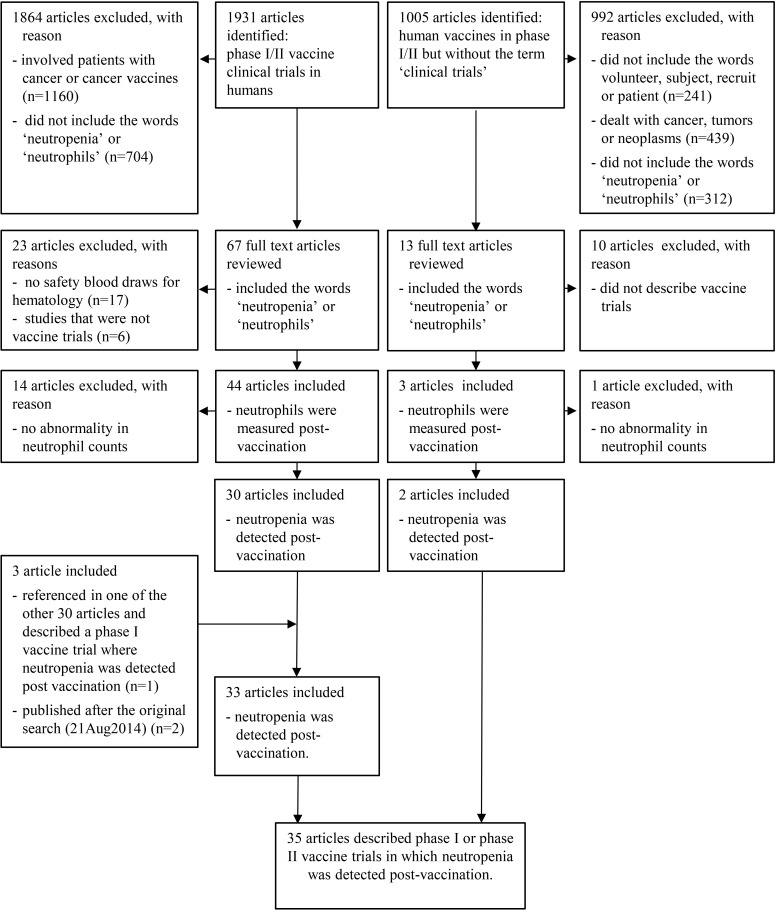
Literature search flow-chart.